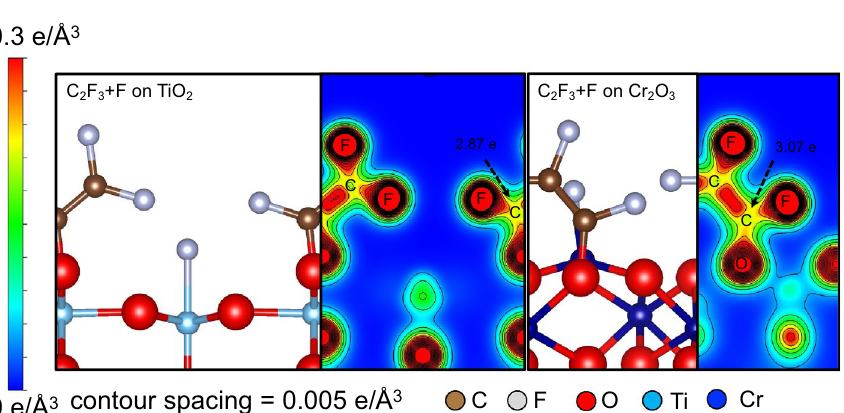
Figure 4. Energies [eV] required to dissociate one F from TFE in the presence of TiO 2 (left panel) and Cr 2 O 3 (right panel). Energies given for different configurations (reaction coordinate) relative to the corresponding reference geometries in the insets ( E =0). Note that it requires 5.3 eV to dissociate one F from TFE in vacuum.